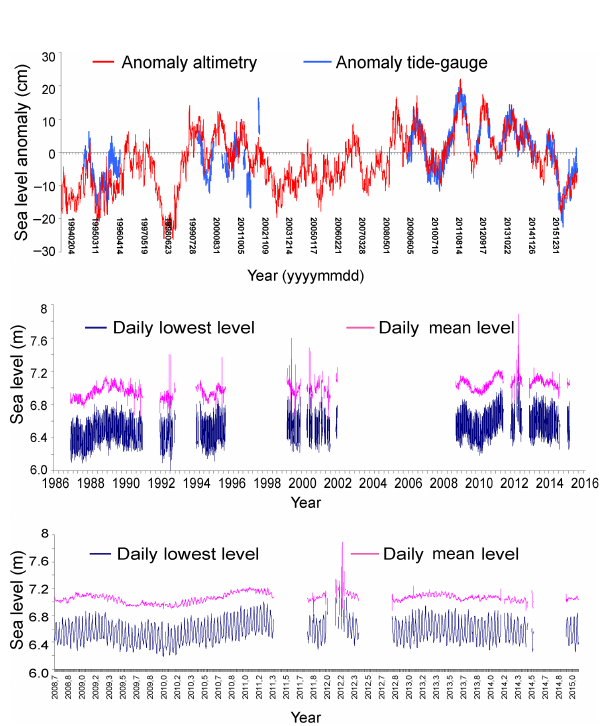
Figure 3. Sea-level data from the Bitung (east North Sulawesi) tide-gauge, referenced against Bako GPS station. On top, sea level anomalies measured by the Bitung tide-gauge station (low-quality data), and overlaid on altimetry ADT anomaly data for the 1993– 2016 period. Note the gaps in the tide-gauge time series. Middle: Bitung tide-gauge sea level variations (high-quality data, shown here from 1986 till early 2015) with daily mean and daily lowest values. Bottom, a close-up for the 2008–2015